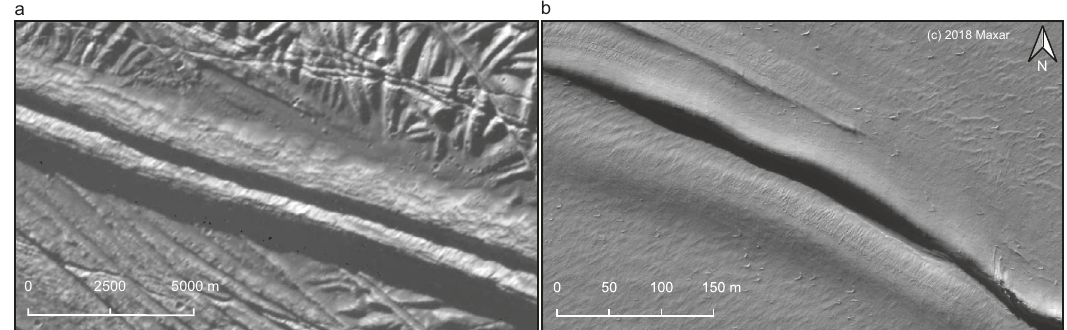
Fig. 1 Surface imagery comparison of a double ridge on Europa and Earth. a Europan double ridge in a panchromatic image from the Galileo mission (image PIA00589). The ground sample distance is 20 m/pixel. b Greenland double ridge in an orthorecti fi ed panchromatic image from the WorldView-3 satellite taken in July 2018 (© 2018, Maxar). The ground sample distance is ~0.31 m/pixel. Signatures of fl exure are visible along the ridge fl anks, consistent with previous models for double ridges underlain by shallow sills 28 .